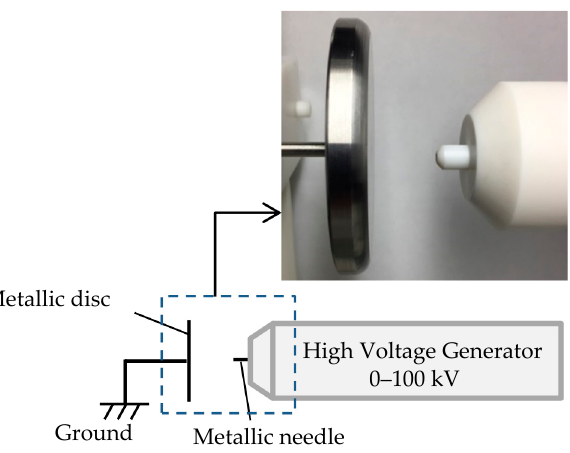
Figure 11. Diagram of the Experimental equipment for corona discharge observation.